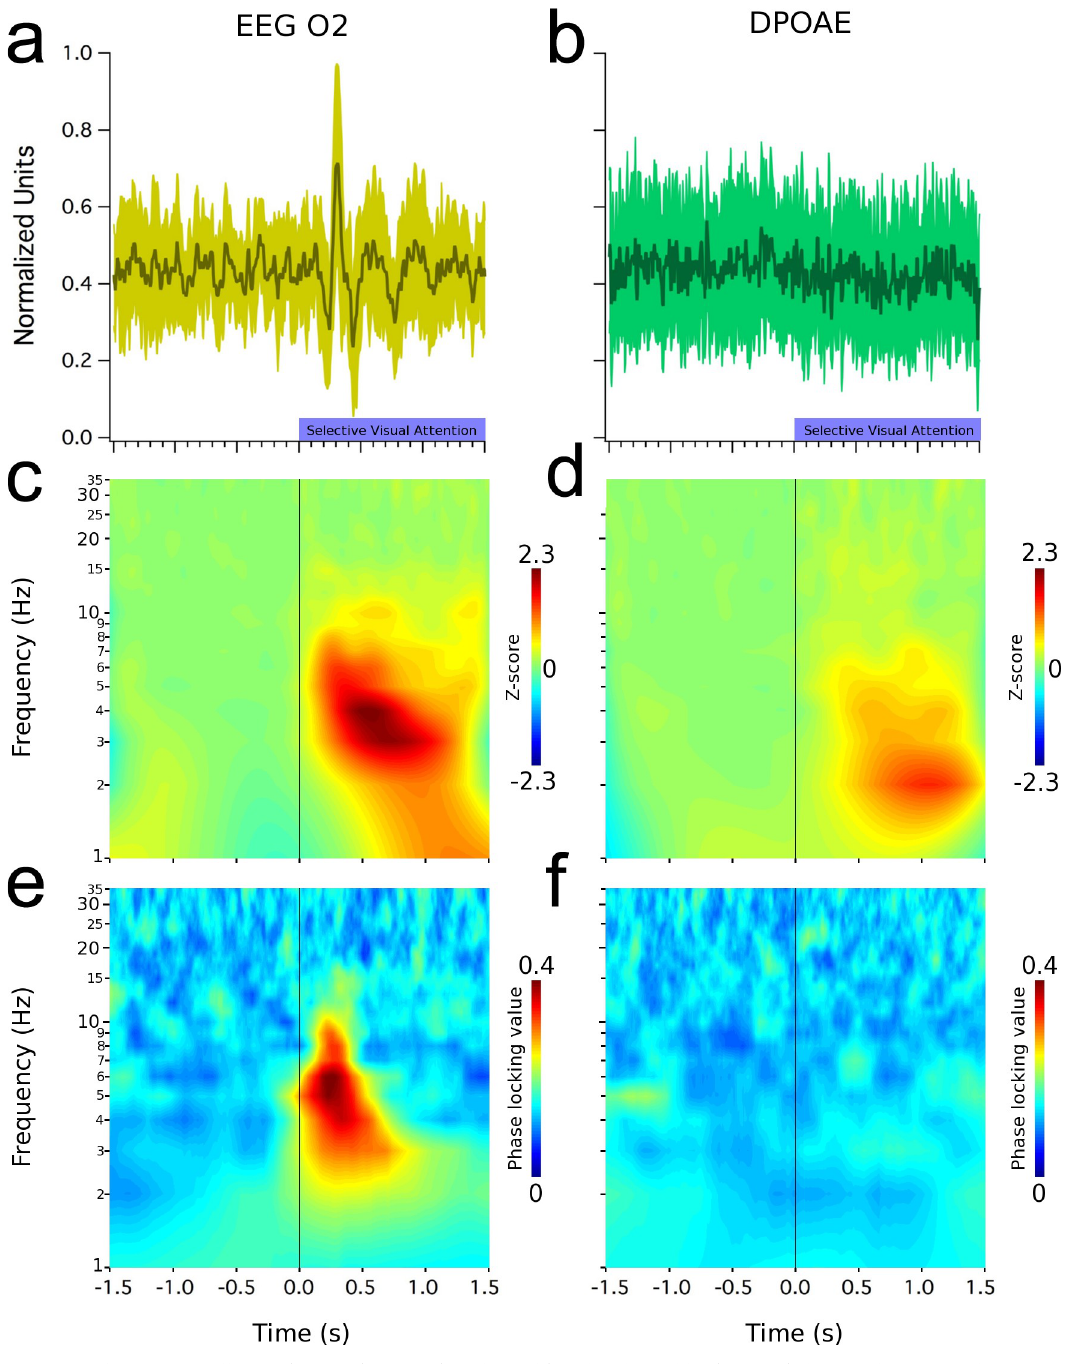
Fig 3. Low-frequency oscillations ( < 10 Hz) in EEG (O2 electrode) and in the cochlea (DPOAE) during selective visual attention. All graphs represent grand average data. Left column shows (a) a visual evoked potential recorded from the right occipital cortex (mean latency: 340 ± 7 ms), (c) time spectrum and (e) increased phase locking values of these brain oscillations. Right column shows (b) a lack of evoked effects in DPOAE amplitudes, while (d) low frequency induced oscillations can be observed between 1 and 7 Hz. (f) Notice the presence of a small region of phase lock value increase at around -1200 ms, while in the rest of the graph there is no phase locking in cochlear oscillations. Shaded green areas in (a) and (b) represent data dispersion ( ± 1 standard deviation).